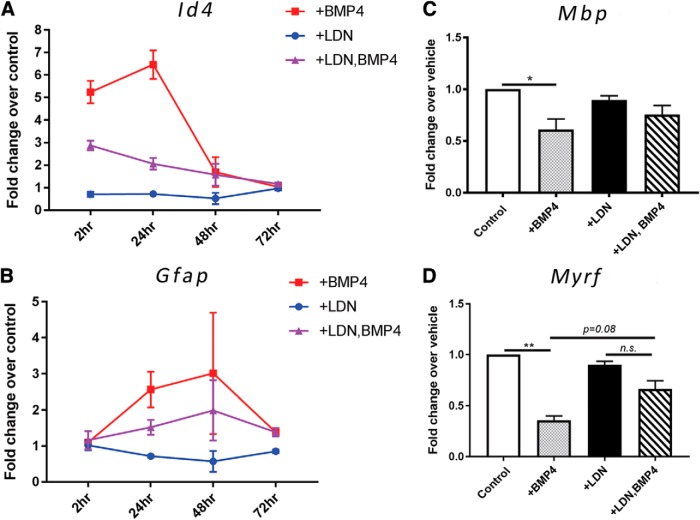
Inhibiting BMP4/BMPRI signaling in OPCs alters the expression of transcription factor Id4 and Gfap, but not Mbp or Myrf. A, B, qRT-PCR analysis of Id4 and Gfap transcript levels from OPCs cultured in differentiation media and treated with LDN-193189, BMP4, or both, or vehicle (control) over various time points. *BMP4 significantly increased the level of Id4 transcripts at 2 and 24 h compared with the control, and this upregulation is blocked by pretreatment with LDN-193189 before BMP4 exposure. *Gfap expression was also significantly reduced by pretreatment of OPCs with LDN-193189 before BMP4 exposure. C, D, qRT-PCR analysis of myelin protein gene Mbp and key myelination transcription factor Myrf from OPCs treated with LDN-193189, BMP4, or both, or vehicle over 24 h. BMP4 significantly reduced the expression level of both Mbp and Myrf genes, with this effect reduced by LDN-193189 pretreatment; N = 3 independent cultures/group). *p < 0.05, **p < 0.01.